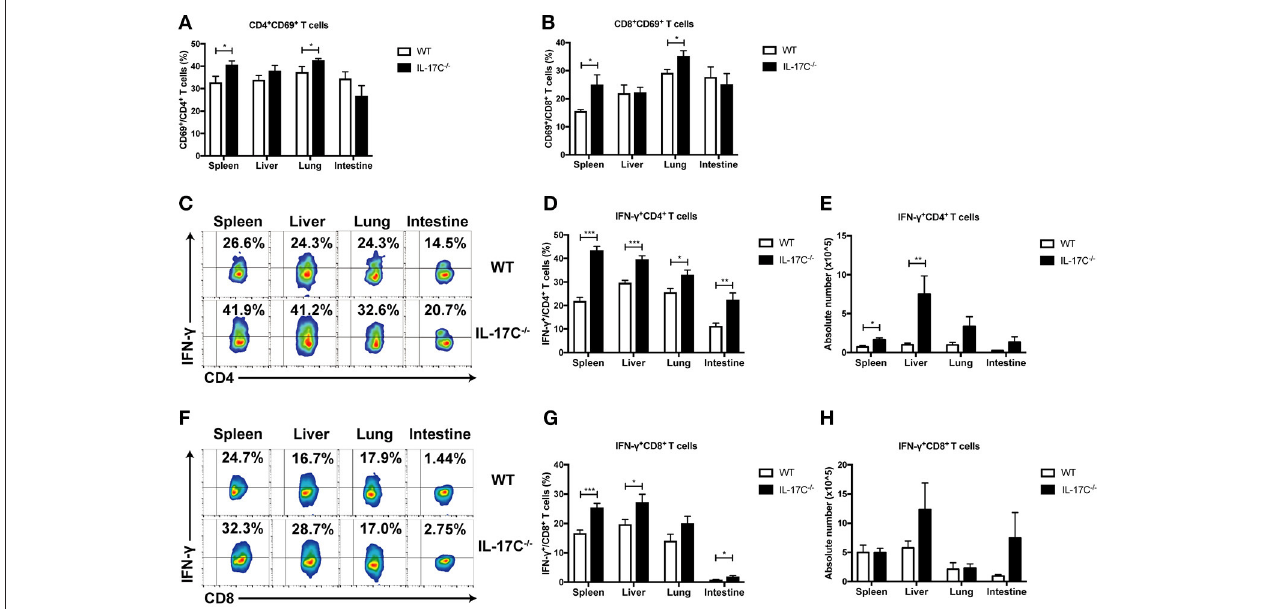
FIGURE 2 | IL-17C inhibits donor T cell responses during allo-HSCT. BALB/c recipients were lethally irradiated and transplanted with 1 × 10 ∧ 7 bone marrow cells and 5 × 10 ∧ 6 splenocytes from WT or IL-17C − / − mice, respectively. Percentages of donor T cell subsets were analyzed by FACS; n = 6–7 per group. Populations of activated CD4 + ( A ) and CD8 + ( B ) T cells were detected in spleen, liver, lung, and intestine 14 days post-transplantation. Populations of IFN- γ -producing CD4 + T ( C,D ) and CD8 + T cells ( F,G ) were examined by intracellular staining. Absolute cell numbers of Th1 and Tc1 cells were calculated ( E,H ). Data are representative of at least three experiments and presented as mean ± SEM. * P < 0.05, ** P < 0.01, *** P < 0.001.